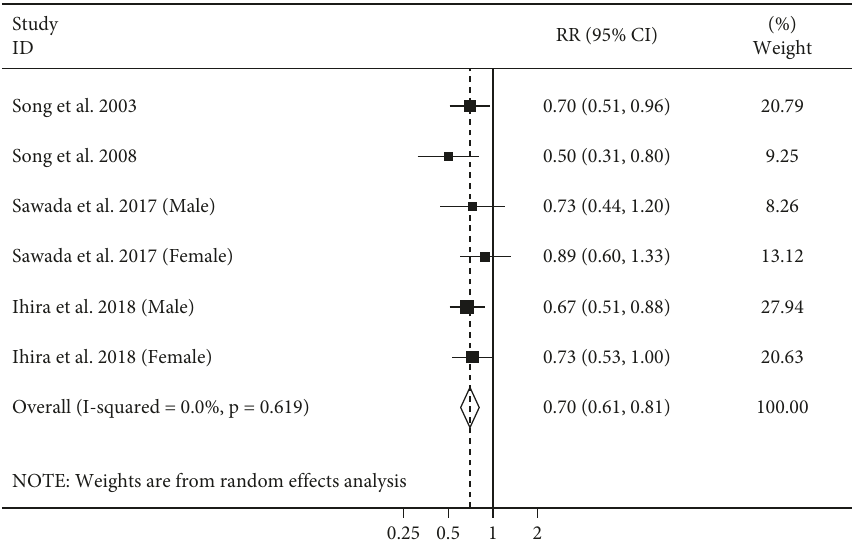
Figure 6: Forest plot for the association between adult height and risk of hemorrhagic stroke mortality by comparing the highest and lowest height. Horizontal lines represent 95% CIs. Diamonds represent the pooled estimates from the random-effects analysis. RR: relative risk; CI: confidence